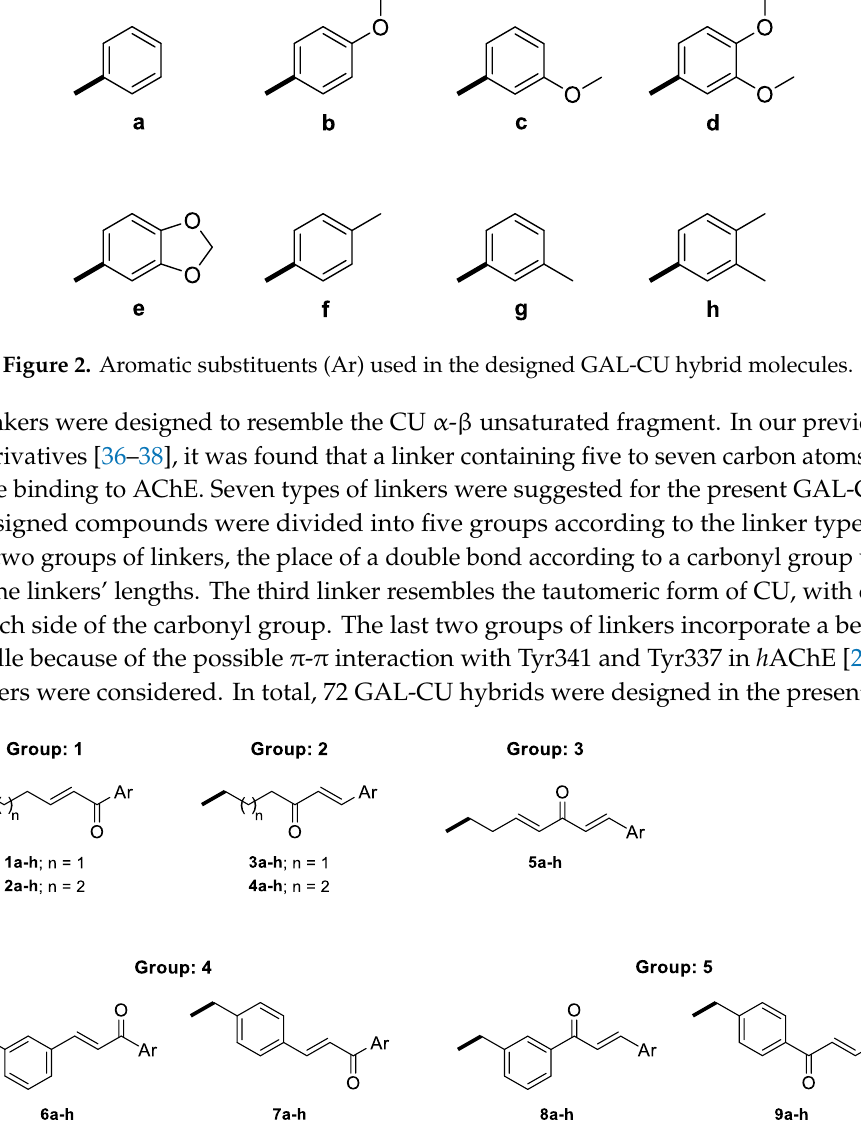
Figure 1. Common structure of the designed GAL-CU hybrid molecules.